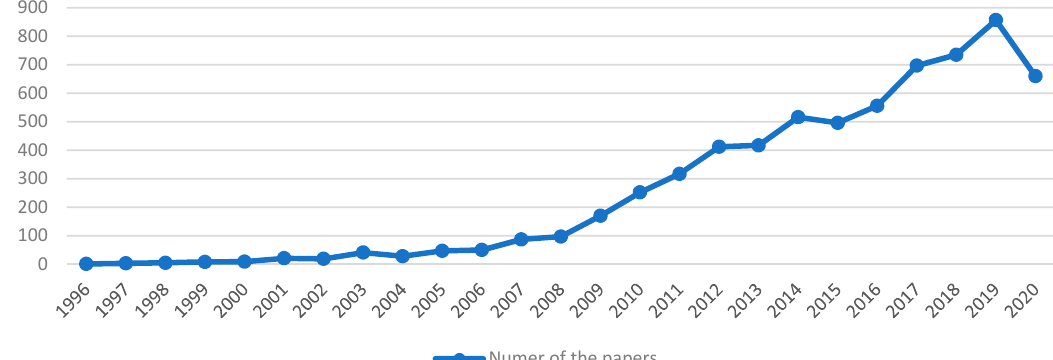
Figure 1. The publication activities in Scopus on green electricity production technology (source: developed by the author based on Scopus).